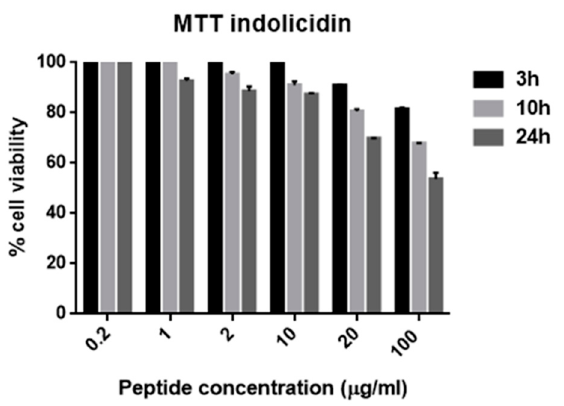
Figure 5. Cytotoxicity evaluation of indolicidin via MTT assay. Vero cells were treated for 3, 10, and 24 h with different concentrations of NPs ( μ g/mL).